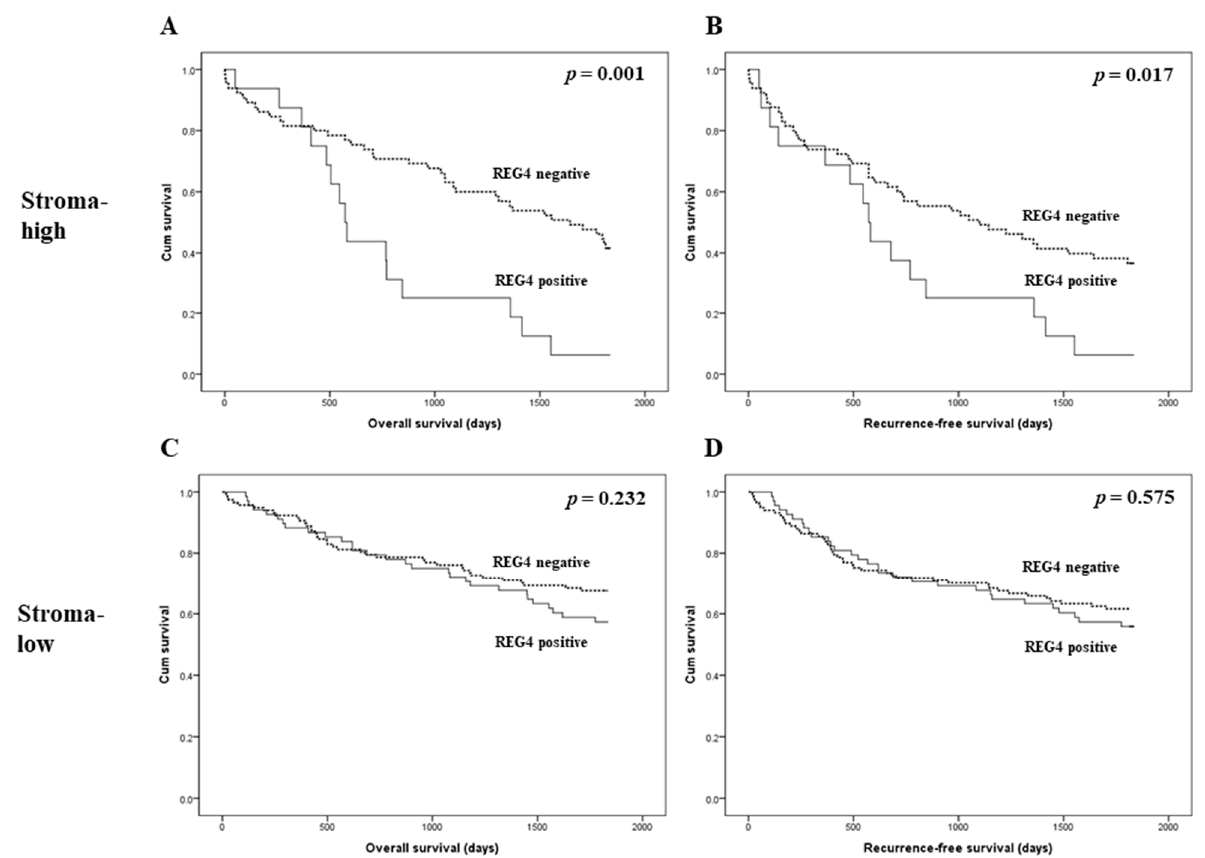
Figure 3. Kaplan-Meier analysis of patient survival according to REG4 expression and intratumoral stroma in colorectal cancer. ( A , B ) Overall and recurrence-free survival according to REG4 expression in colorectal cancer cases with high stroma. ( C , D ) Overall and recurrence-free survival according to REG4 expression in colorectal cancer cases with low stroma.